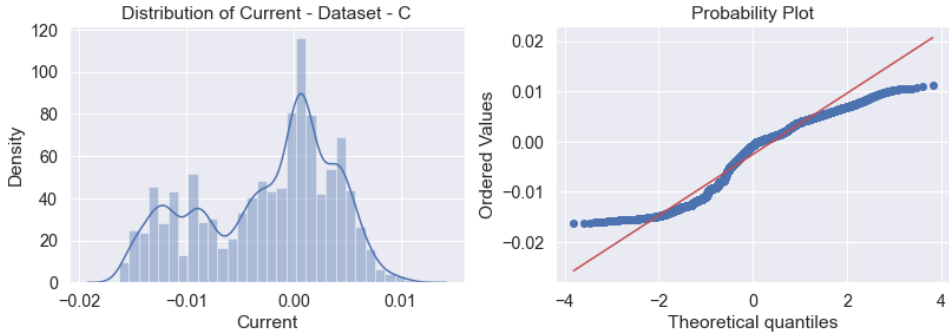
Figure 16. Density and probability plots of Dataset